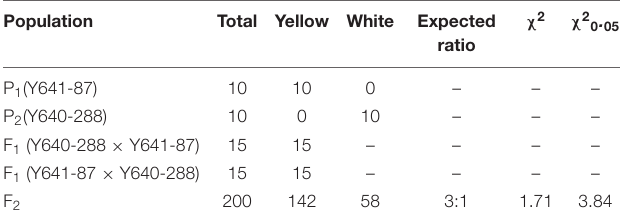
TABLE 1 | Genetic analysis of the white flower trait in crosses between Y641-87 and Y640-288. Population Total Yellow White Expected